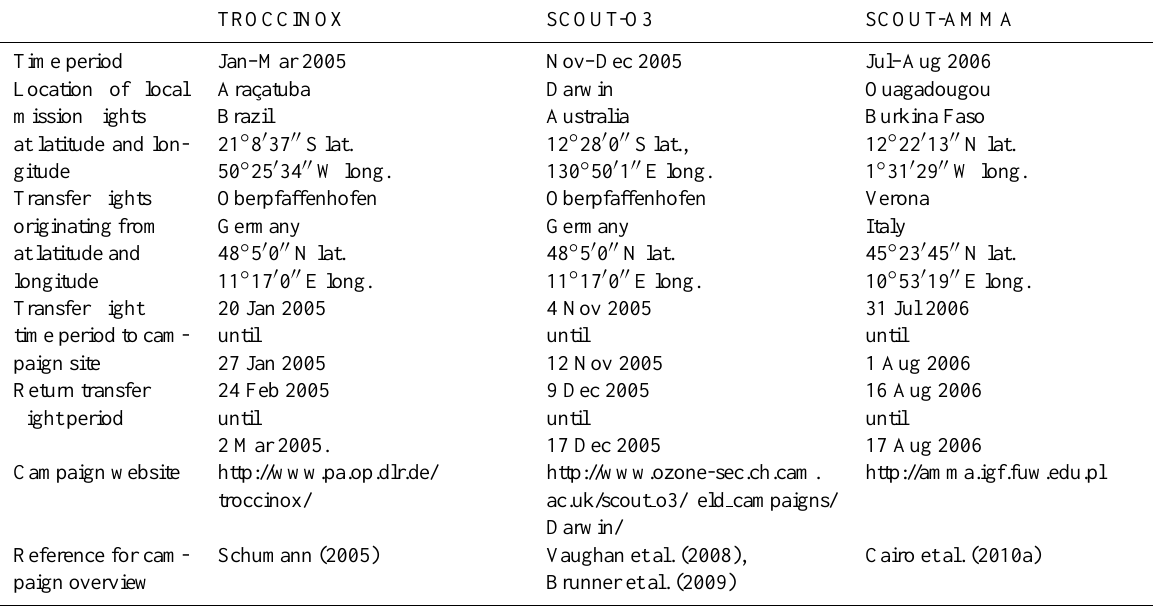
Table 1. Locations and times of the tropical campaigns TROCCINOX, SCOUT-O3, and SCOUT-AMMA with the Russian M-55 “Geophys- ica” and the German DLR Falcon-20 research